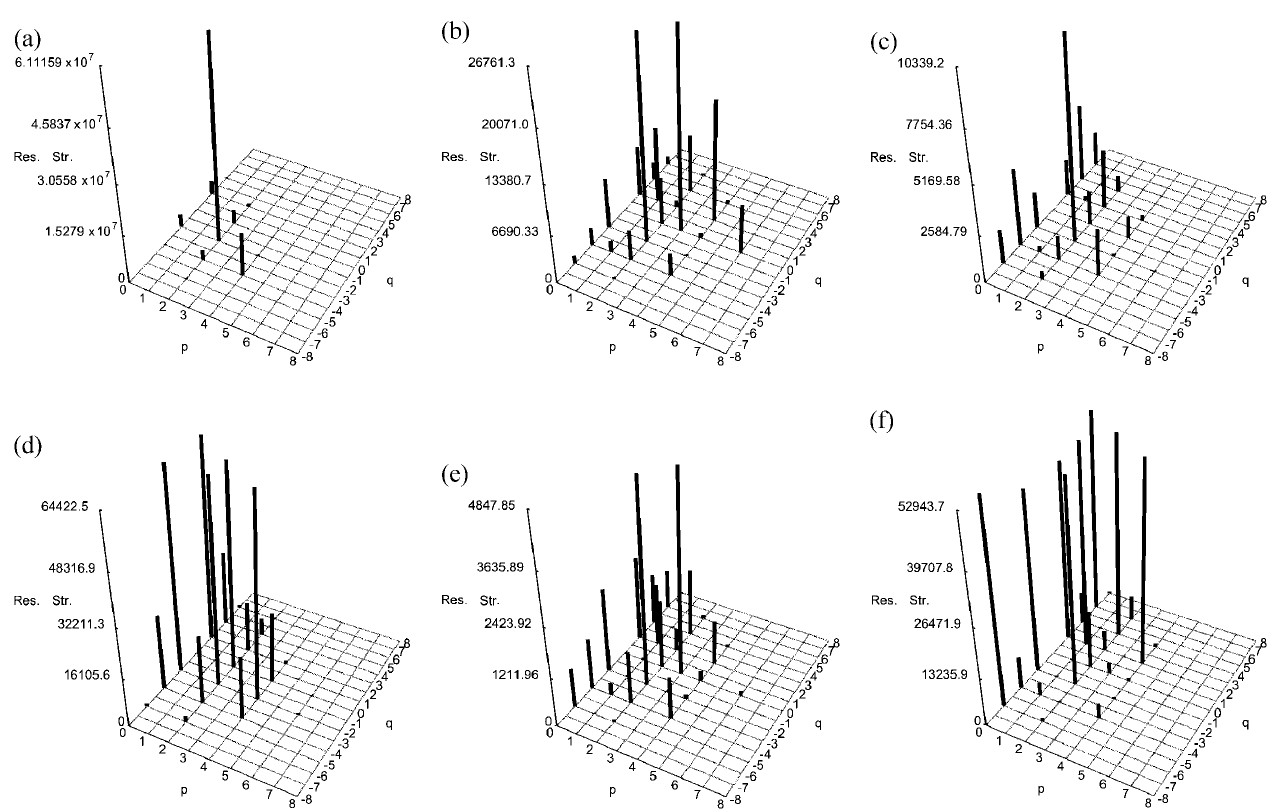
FIG. 12. Resonance strengths of on-energy particles along the diagonal in action space, at a distance from the origin that corre- sponds to the approximate dynamic aperture, magnet aperture of 75 mm, for all six types of fringe fields. The following fringe field types are depicted: (a) default dipole, (b) default quadrupole, (c) default sextupole, (d) LHCHGQ lead end, (e) two parameter Enge function, and (f) GSI QD